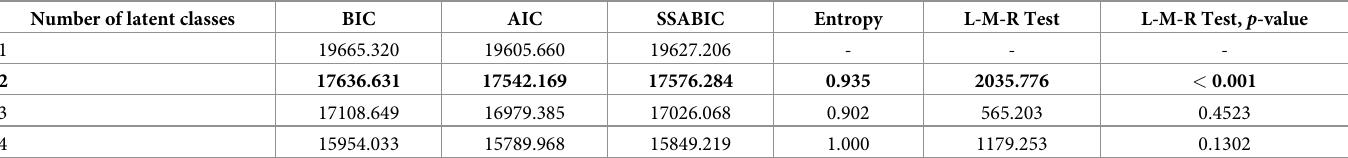
Note . Estimates were computed using sampling weights unless otherwise specified. The chosen model is highlighted in bold in the table. BIC = Bayesian Information Criterion; AIC = Akaike’s Information Criterion; SSABIC = Sample-Size Adjusted Bayesian Information Criterion; L-M-R Test = Lo-Mendell-Rubin Adjusted Likelihood Ratio